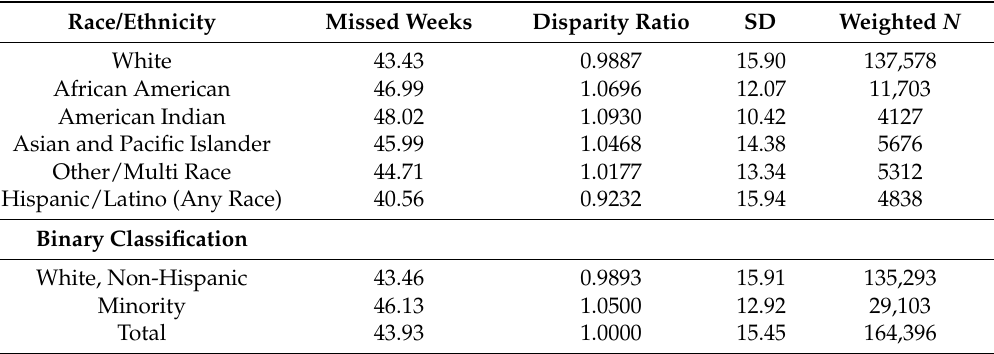
Table 3. Weeks of work missed due to illness, ages 16–65 (2005–2007).